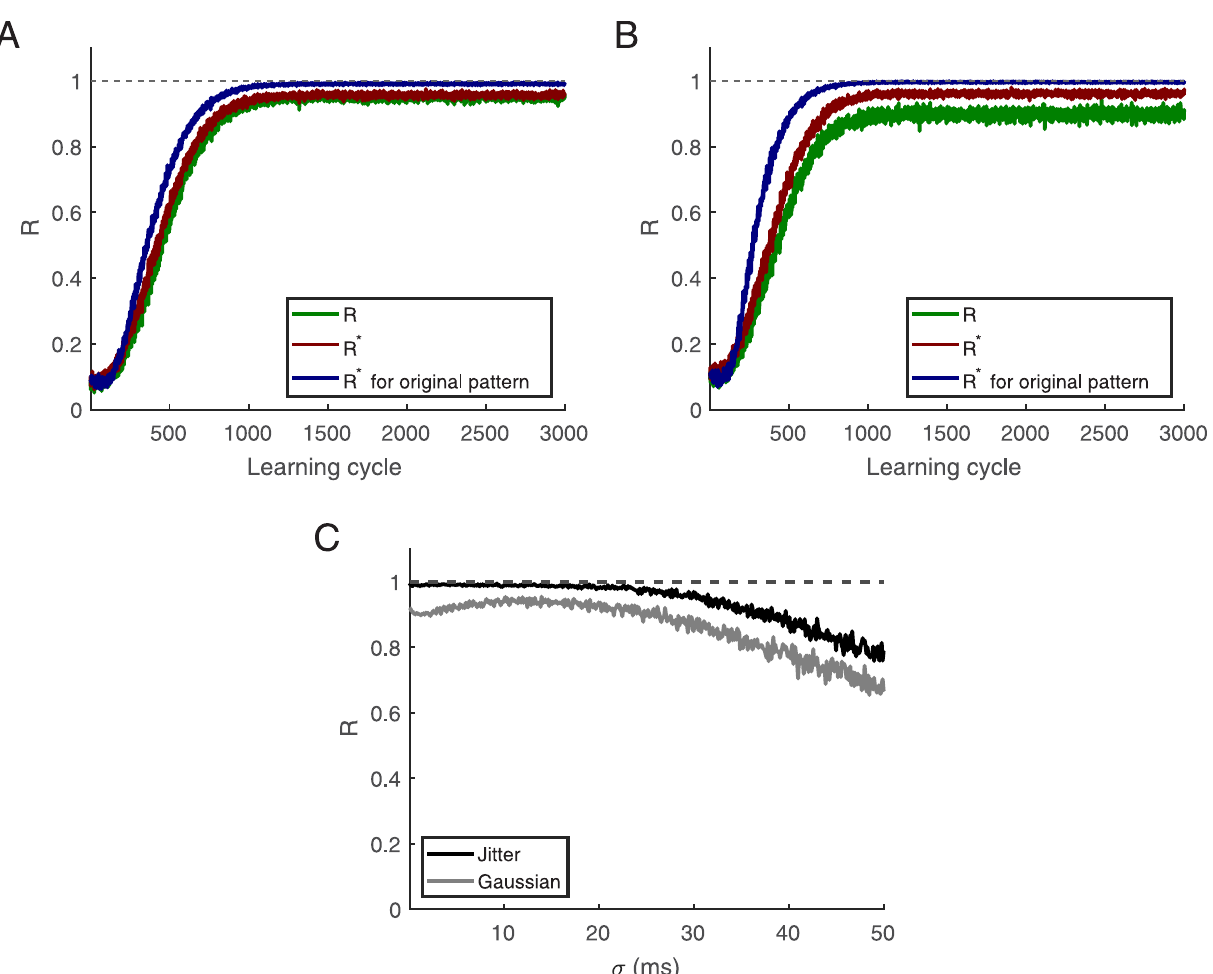
Fig 7. Learning and testing with jittered patterns and Poisson spike rates. (A) The training patterns are perturbed by jittering the spikes with a Gaussian distribution with a standard deviation of σ = 20 ms and a zero mean. Blue represents testing with the original pattern ( R ), the green line represents testing with jittered data including simulations with no spikes (i.e. R ), and the red line represents the performanc when testing with jittered data but dropping episodes with no spikes (i.e. R � ). (B) Learning from Poisson spike rates: the blue line represents R when testing with the original pattern, the green line represents testing with Poisson spike rates, including those with no MP spikes ( R ), and the red line shows R � where episodes with no spikes are ignored. (C) The black and gray lines represent tests of jittered and Poisson spike rates where the weights were trained with σ = 20 ms, respectively. This figure is based on an average of 500 simulations with 500 afferents. The training epoch is 1000 ms, L